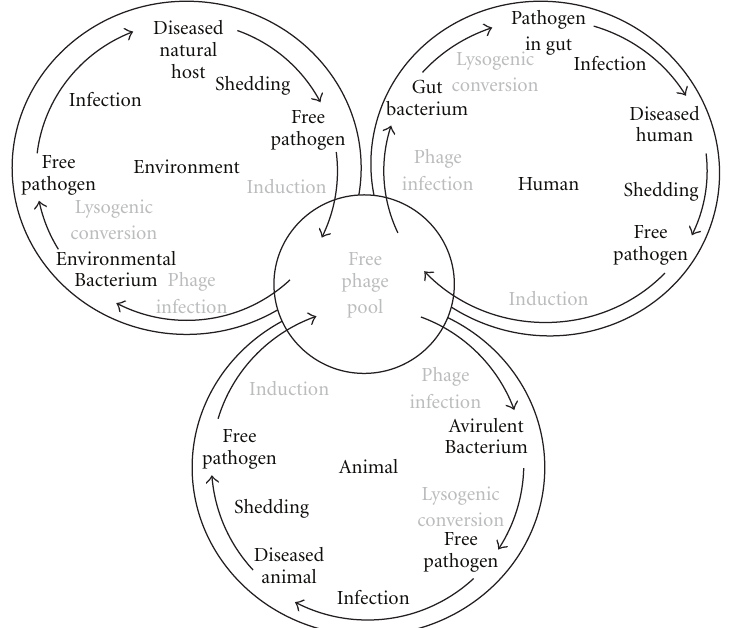
Figure 4: Free phage pool of exotoxin genes. Proposed scenarios for how exotoxin-encoding phage might be maintained in the environment and produce human pathogens through genetic exchange between the free phage pool and the natural, human, and animal environments. Light grey writing indicates phage/host interaction and potential for horizontal gene